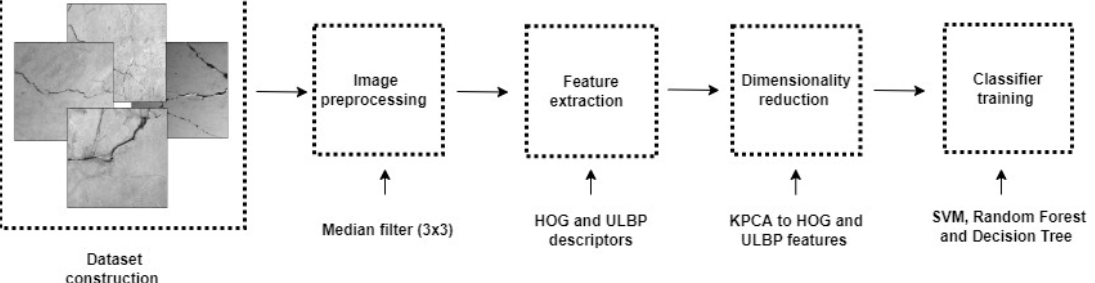
Figure 4. Experimental setup.